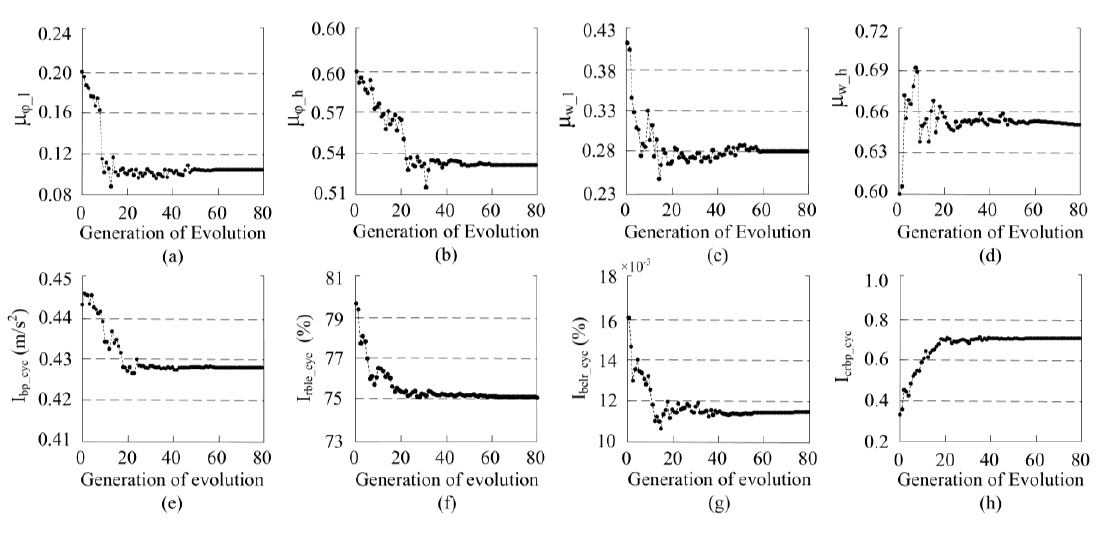
Figure 11. Average value of variables changes in the iterative process: ( a ) µ ϕ _ l ; ( b ) µ ϕ _ h ; ( c ) µ w _ l ; ( d ) µ w _ h ; ( e ) I bp_cyc ; ( f ) I rble_cyc ; ( g ) I bclr_cyc ; and ( h ) I crbp_cy c Table 3. Results of the variables.